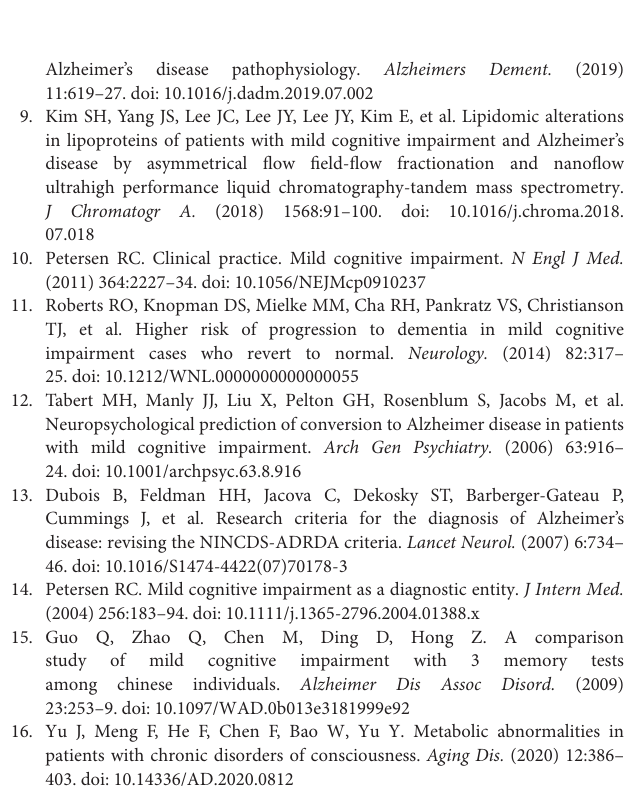
Supplementary Table 2 | The metabolite identification of RT-MZ in POS mode. Supplementary Table 3 | Prediction results of multiple machine learning models. Supplementary Table 4 | The post hoc analysis of HC, MCI, AD